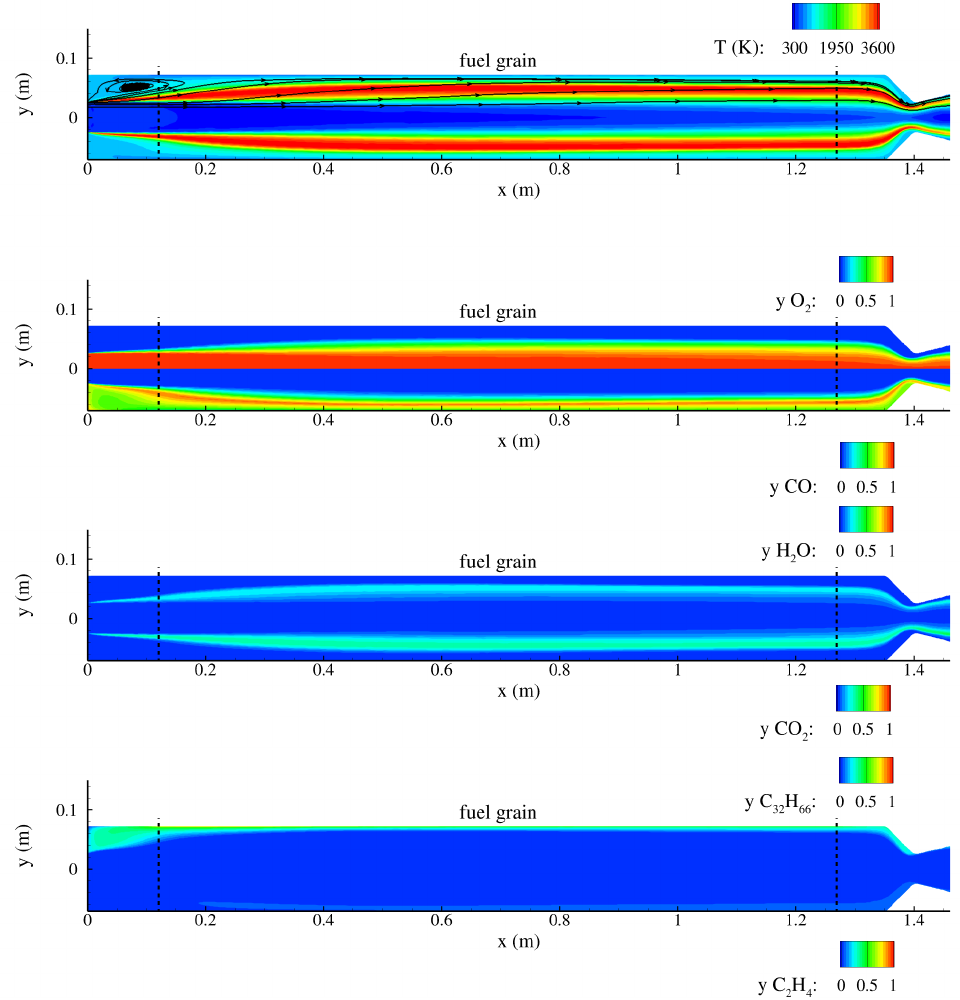
Figure 11. Temperature (with streamtraces) and species mass fractions from numerical simulations of test L01 of set 2 (see Table 2). Table 3. Wall heat flux contributions on the grain surface for all tests at the average port